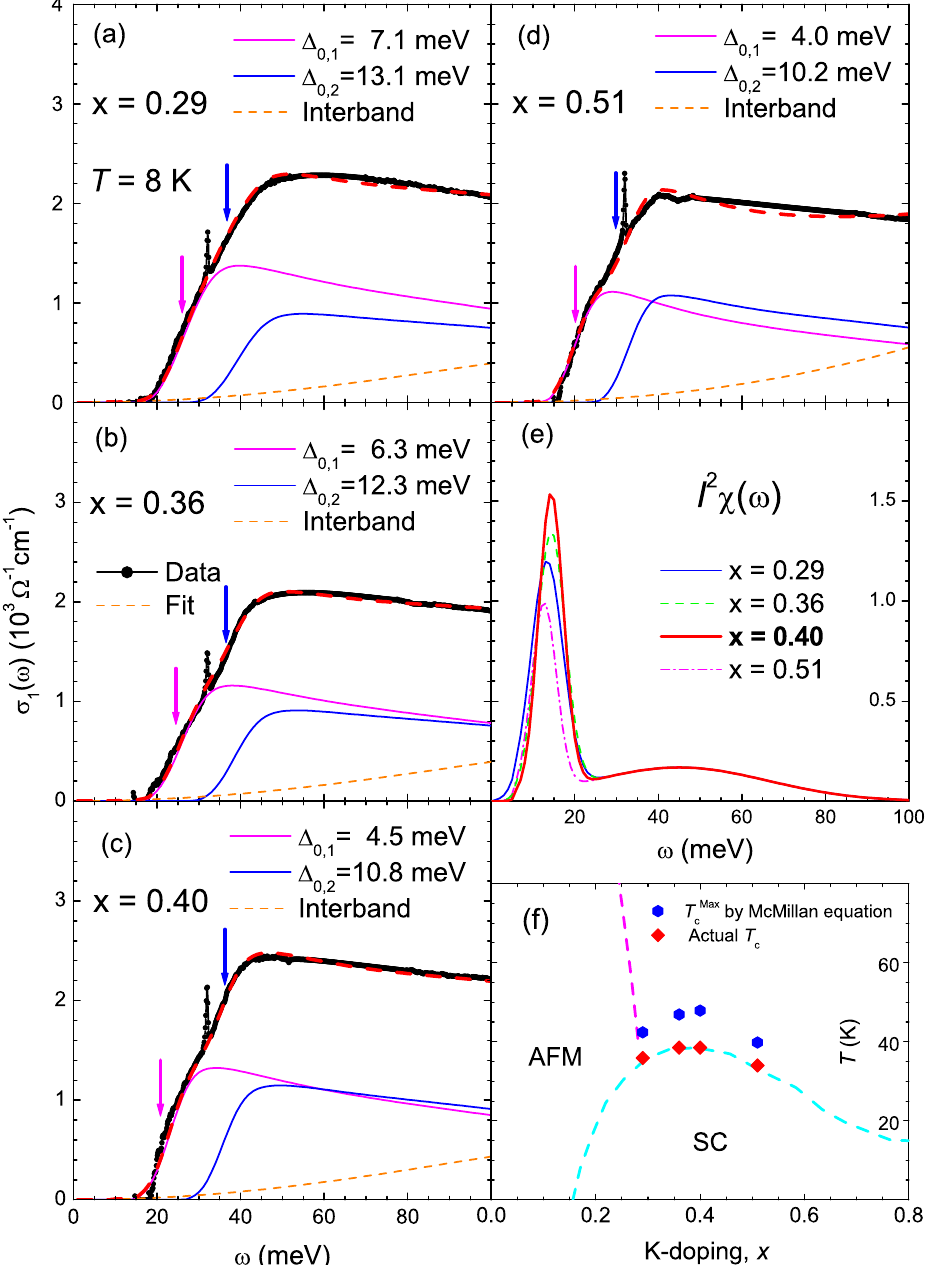
Figure 4. (Color online) ( a – d ) Optical conductivity spectra of K-doped Ba-122 at 8 K (SC state) and their fits; ( a ) x 0.29, ( b ) x 0.36, ( c ) x 0.40, and ( d ) x 0.51. ( e ) Resulting electron-boson spectral density functions = = = = 2 χ(ω) Max ( I ). ( f ) Maximum SC transition temperature ( T c ) and actual measured K-doped Ba-122 was adopted from published literature 39